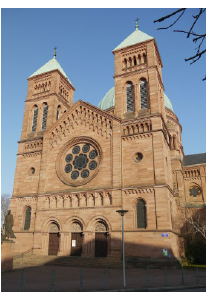
Figure 1. The main façade of the St-Pierre-le-Jeune church, Strasbourg, France built from typical Alsatian red